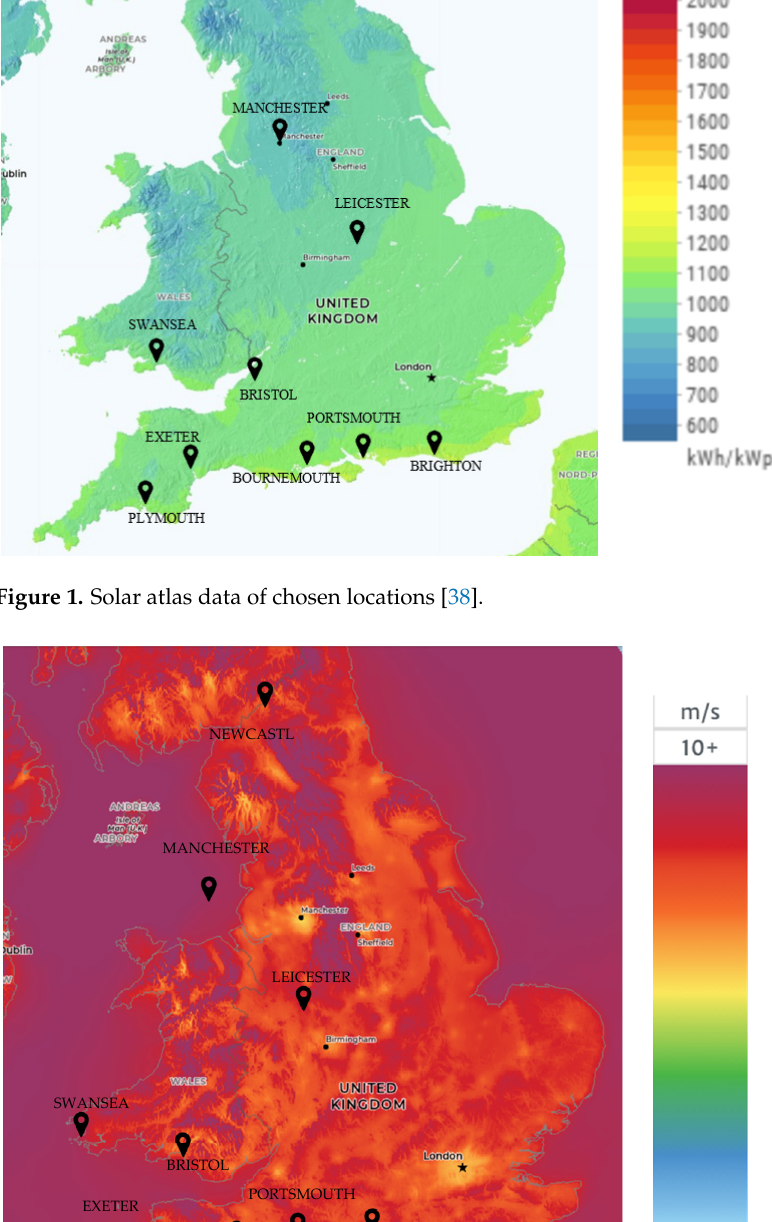
Figure 2. Wind atlas data of chosen locations [38].